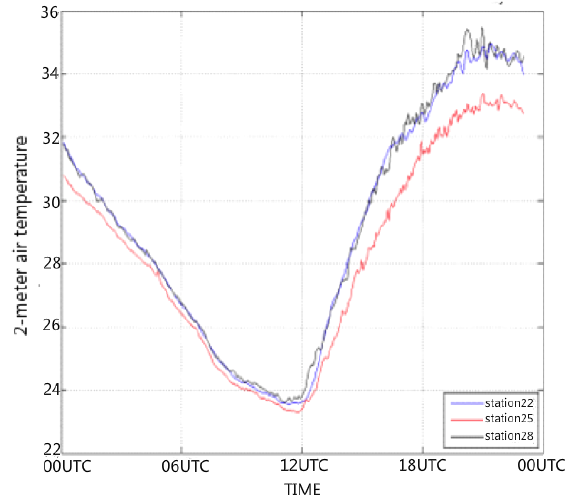
Figure 8. 24 h diurnal variation of 2 m air temperatures (unit in °C) from PNNL HOBO Station No. 22, Station No. 25, and Station No. 28.